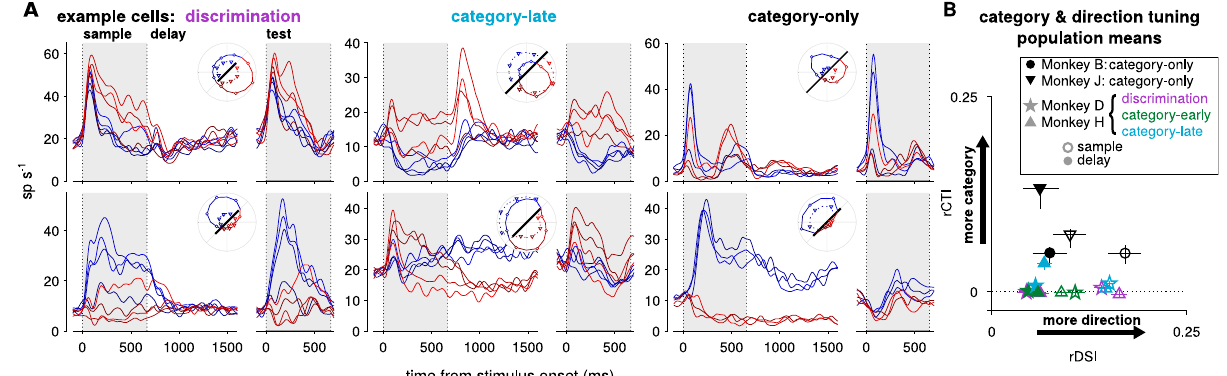
Fig. 2 | LIP recordings during discrimination and categorization tasks. A Mean fi ring rates of six single LIP cells recorded during each task. Colors correspond to the stimulus direction and category. Firing rates aligned to the sample stimulus onsetareaveragedbysampledirection(left),andtheteststimulusalignedratesare averaged over test direction (right). Although motion categories were not part of thediscriminationtask,thedirectionsarelabeledblueorredforconsistency.(Inset polar plots) The mean fi ring rate for each sample direction during the sample stimulus presentation (circles and solid lines; 0 – 650ms after motion onset) and delay period (triangles and dotted lines; 800 – 1450ms after motion onset). The solid black line denotes 20sps − 1 . B Mean category and direction tuning measured